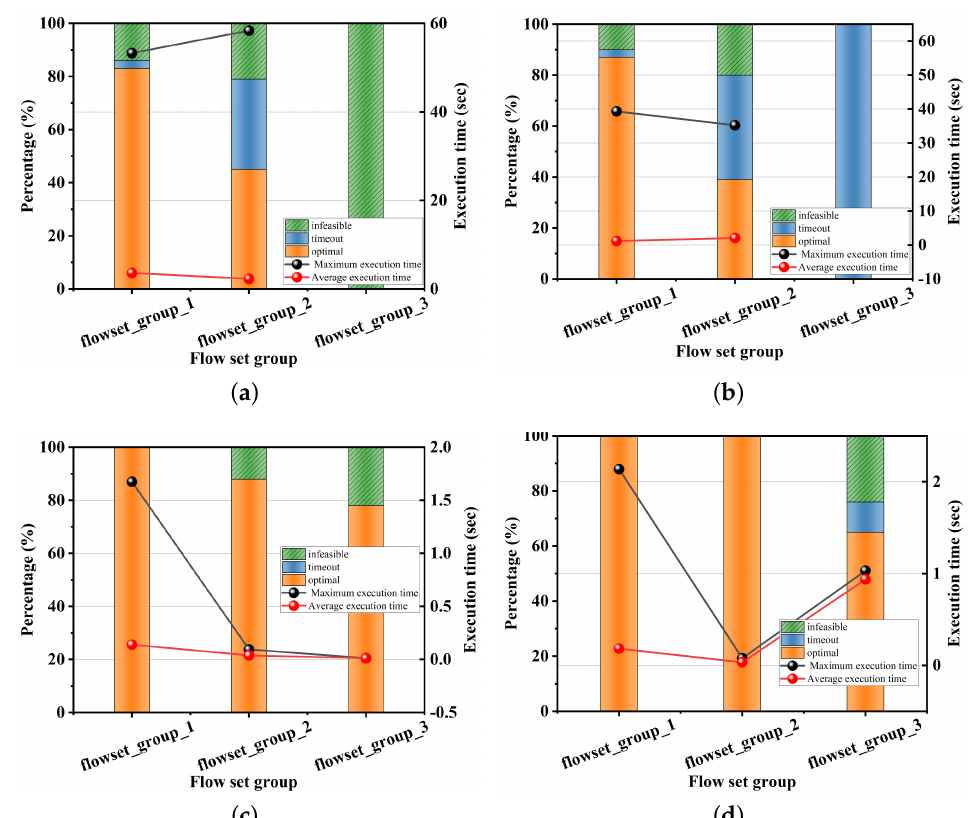
Figure 11. Percentage of solved, timeout, and infeasible schedules and execution time of the SPRF- EtoED, LBF-EtoED, MPFRS-FC, and APCRS-FC for 100 test cases with 20 flows, tested in MM network.